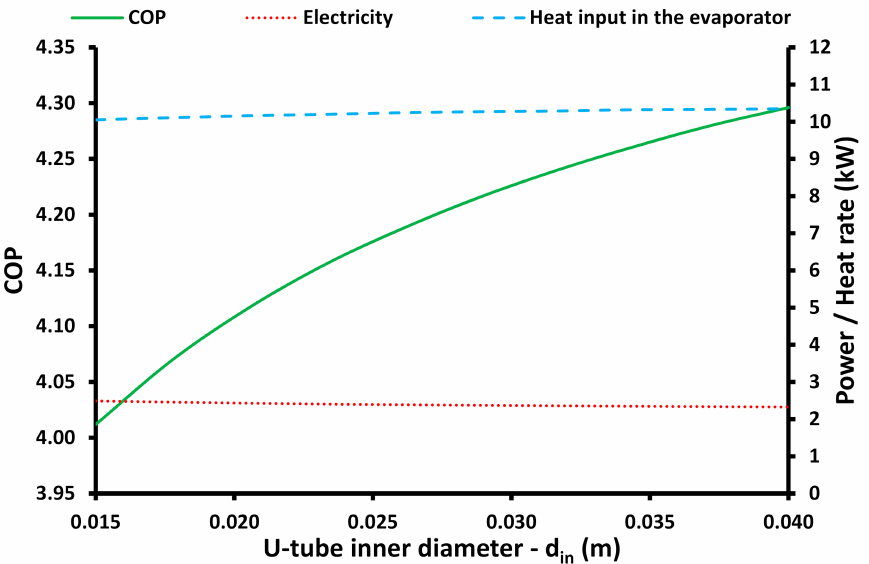
Figure 18. The impact of the U-tube inner diameter on the COP, electricity consumption and heat input in the evaporator.